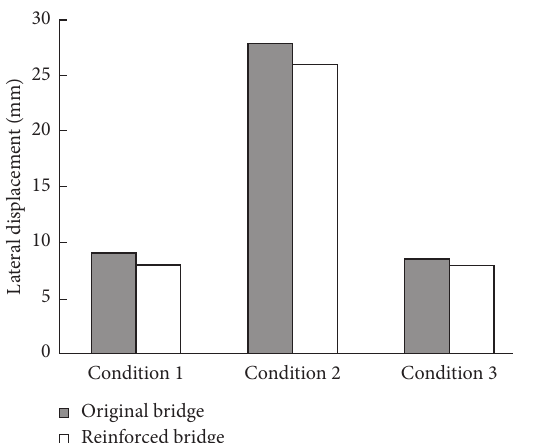
Figure 19: Comparison of peak values of displacement at 1/2L of the upper chord of the bridge before and after reinforcement.